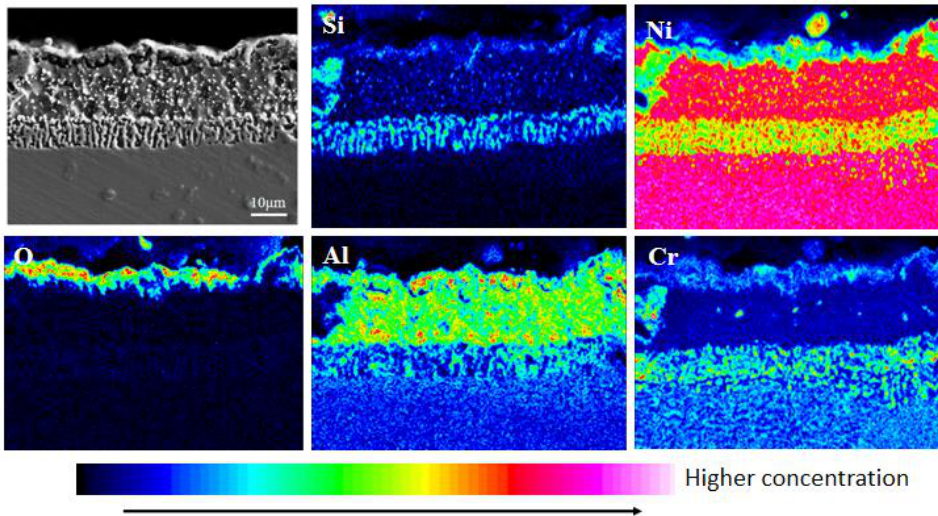
Figure 6. Element distribution of coating section after pre-oxidation at 900 °C for 1 h.